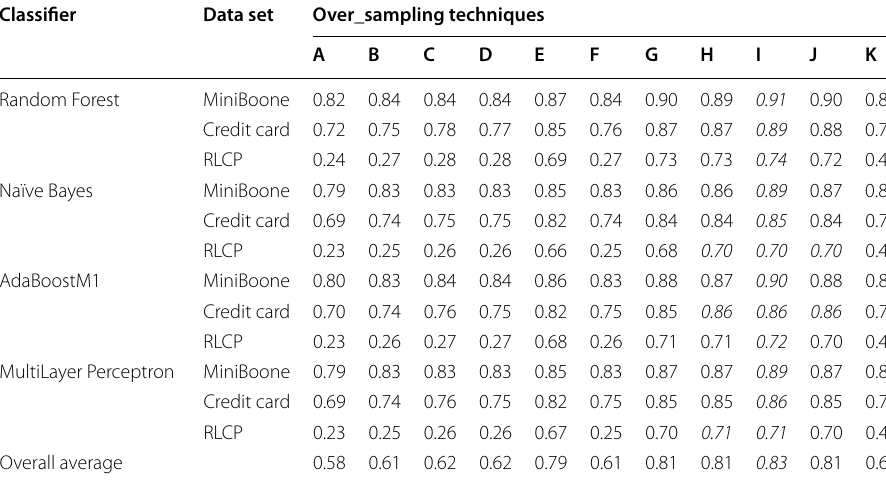
Italic values indicate highest result Table 11 AUC values for binary-class data set